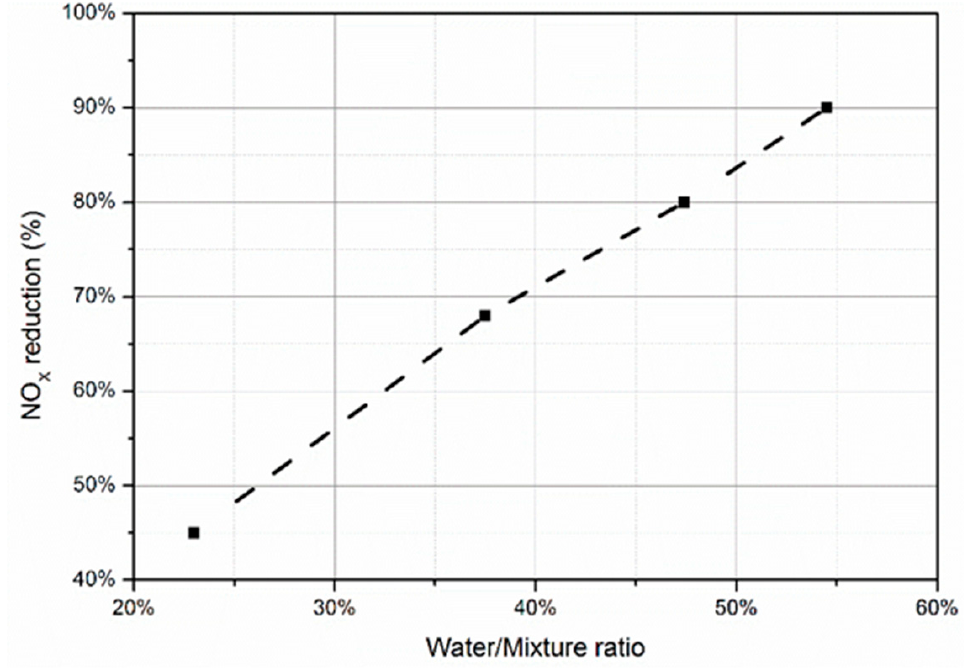
Figure 6. Influence of percentage water content in the mixture on NO x reduction (the article does not explicitly specify whether the water content in the mixture was by volume or mass) (based on [99]). Interesting results were obtained during the tests of the Capstone C60 CHP gas turbine, with a modified injection system adapted to burning liquid fuels and a modified engine controller maintaining a constant temperature (950 K) behind the turbine [47]. The research covered the combustion of pure diesel oil (base variant) and FWE included mixtures of diesel fuel with water in a mass ratio of 25%, 37.5% and 50%. As a result of the research, an increase in NO x emission was obtained in the case of the mass addition of water by 25% and 37.5% in relation to the base variant with a downward trend. With the addition of 50% water, the NO x emissions fell below the